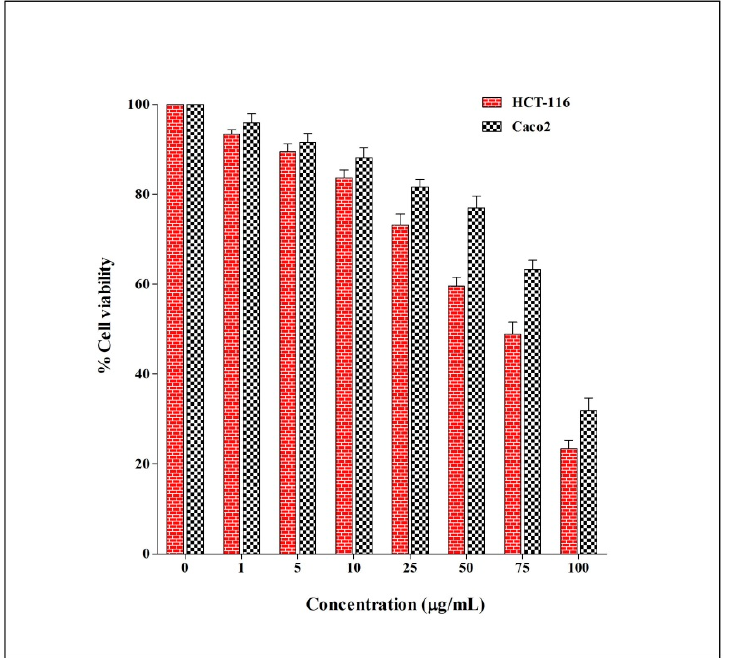
Figure 5. Anticancer activity of E. sativa crude extract on human colorectal cancer cell lines (HCT- 116 and Caco-2) via MTT assay and the results are expressed in a dose-dependent manner. The activity was carried out in triplicate and the data represent the mean ± SD.